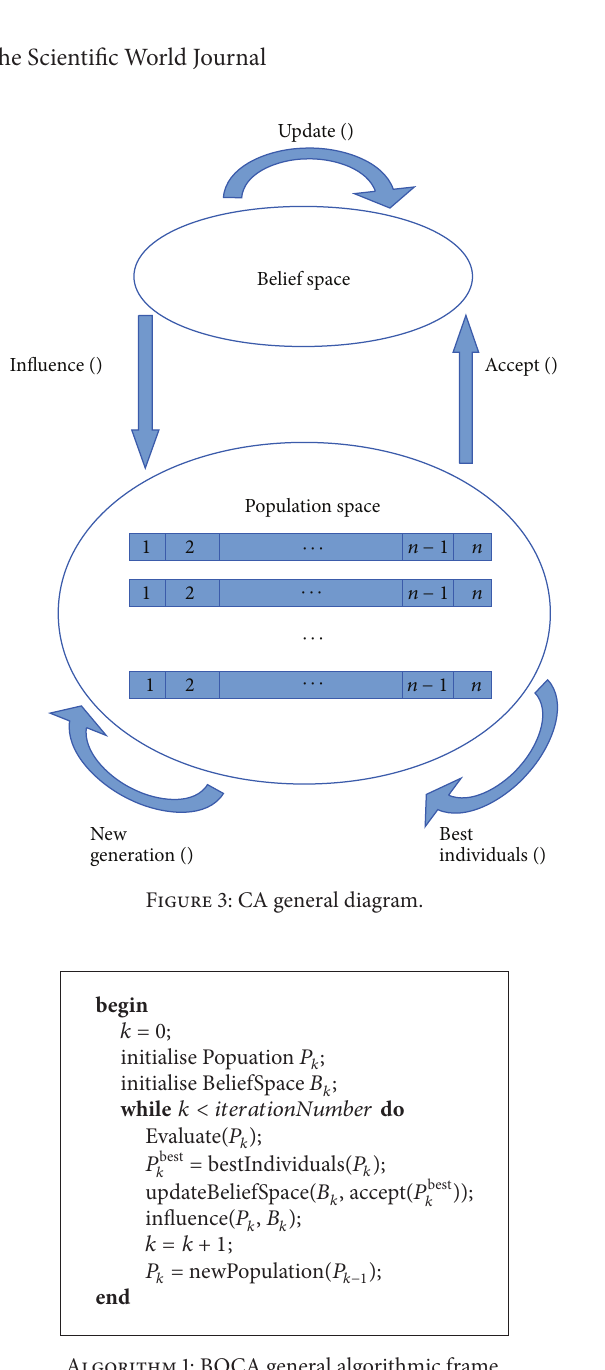
Algorithm 1: BOCA general algorithmic